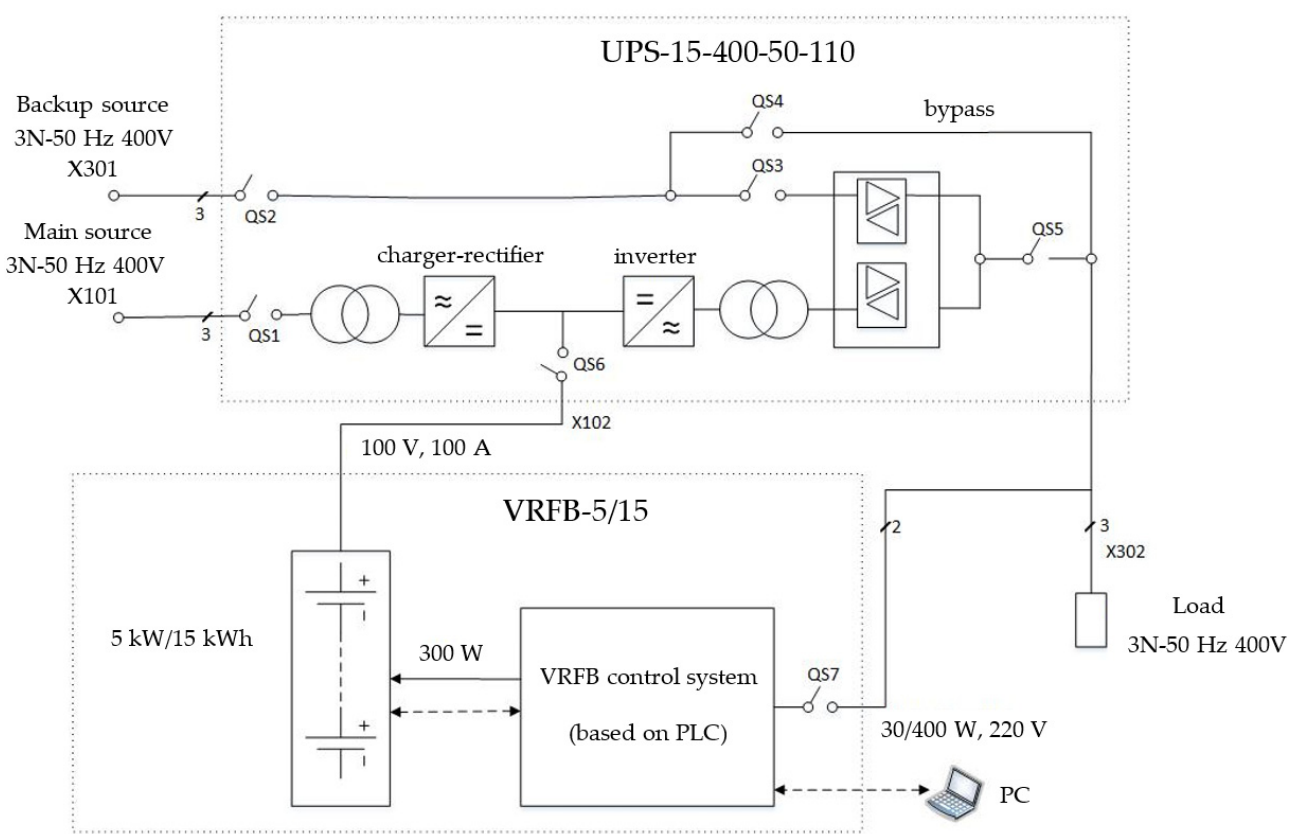
Figure 7. Block diagram of the UPS system based on 10 kW/30 kWh VRFB.